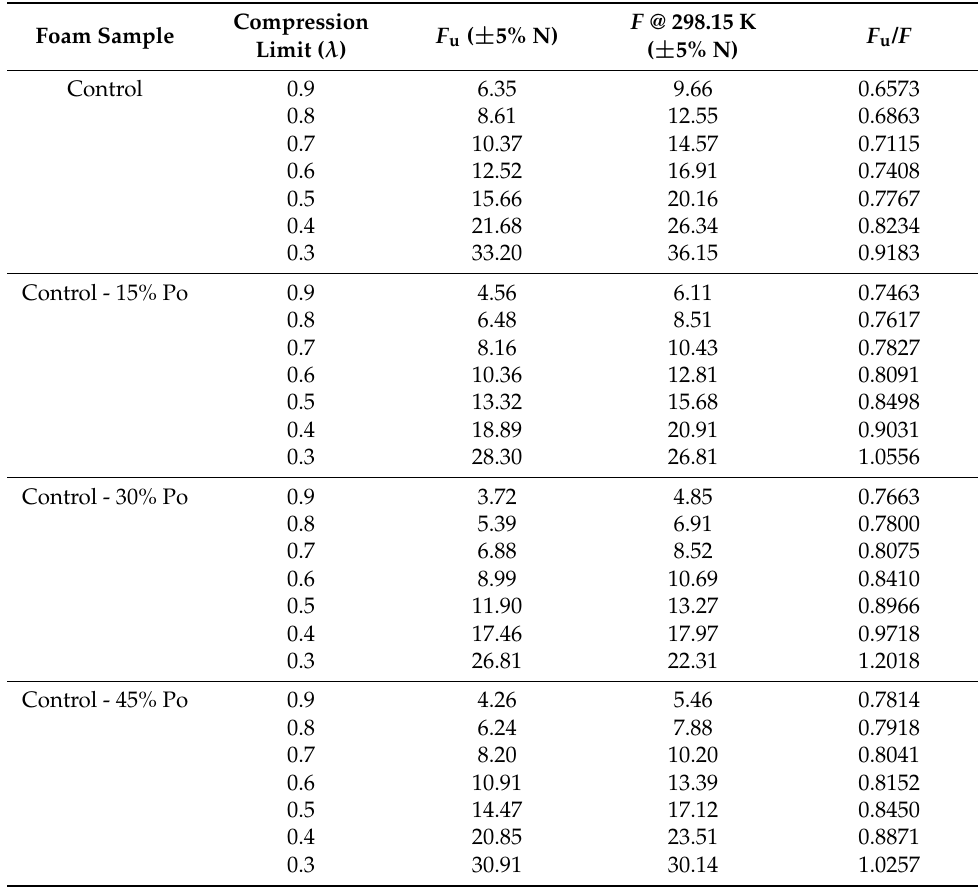
Table 5. The ratio of the internal energy force ( F u ) to the compression force ( F ) of various foam samples for different compression limits at 298.15 K. Foam